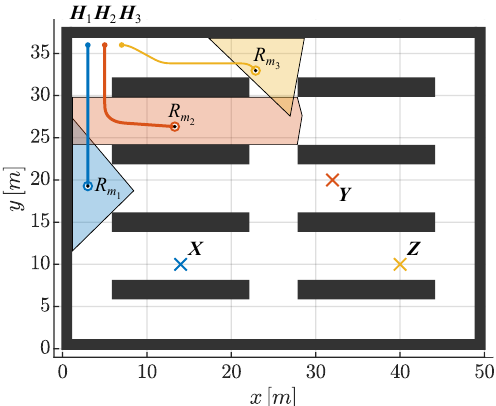
Figure 3. A frame of the simulation of the logistic task showing the mobile robots with their allowed area, their travelled path, and their current